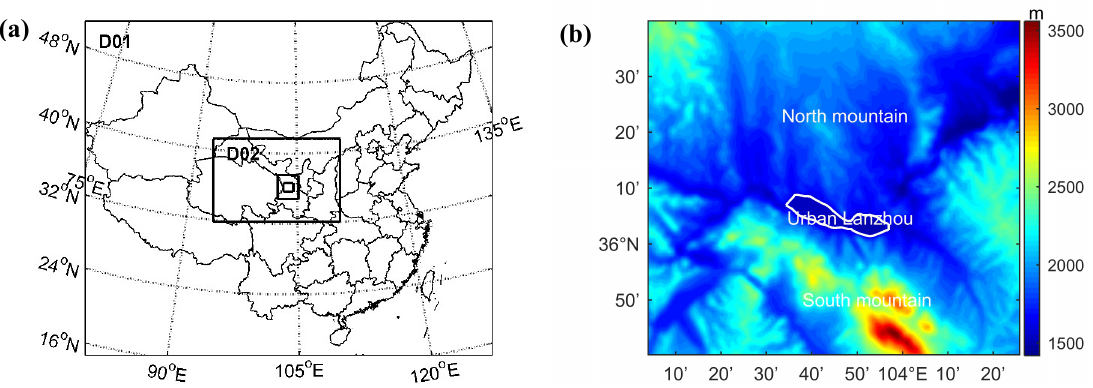
Figure 1. ( a ) Domain setting of the Weather Research and Forecast (WRF), and ( b ) the terrain for domain 4 and the location of Lanzhou.